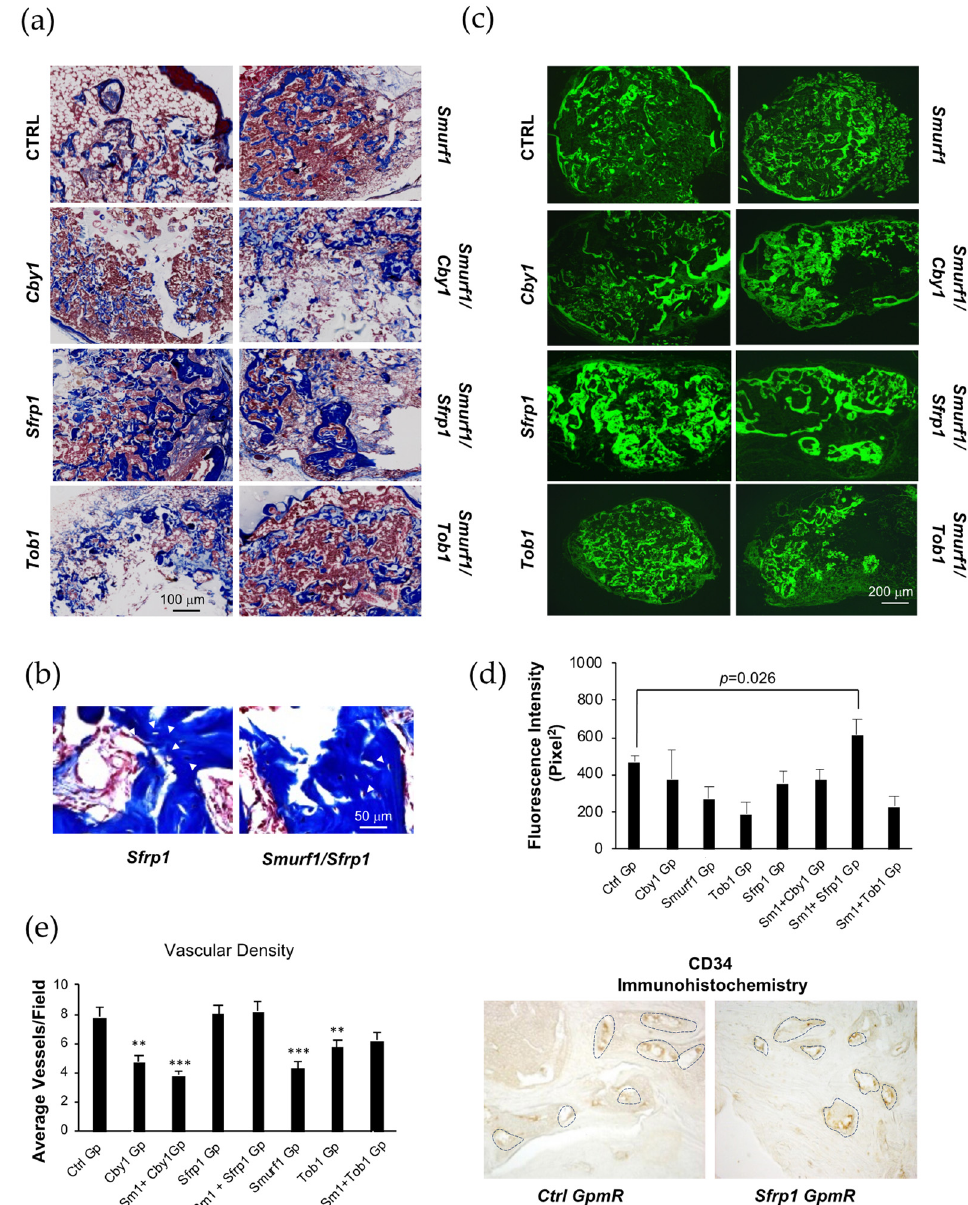
Figure 4. In vivo analysis of the pro-osteogenic effect of the silencing of key osteogenic inhibitors in MSCs. Pictures show histological analysis of sections obtained from representative decalcified implants. All implants were isolated from the same individual. ( a ) Masson–Goldner staining of subdermal implants in mice, showing mineralized matrix. ( b ) Representative images of Masson–Goldner staining at higher magnification. White arrowheads indicate osteocyte-like cells surrounded by lacunae and immersed in the mineralized matrix. ( c ) Histological sections observed under green, fluorescent light show the typical autofluorescence of collagen fibers in the different samples analyzed. ( d ) Bar graph shows quantification of fluorescence signal intensity in the different histological samples performed using ImageJ. Sm1 stands for Smurf1 . One implant of each type was quantified. Values correspond to the average of at least six different areas measured in each of the implants. Error bars represent standard error of the mean values. Sm1 stands for Smurf1 in the Gapmer combinations. ( e ) Immunohistochemistry of vascular marker CD34. Microvascular density was determined by counts of CD34-positive staining blood vessels. Sm1 stands for Smurf1 in the Gapmer combinations. The graph shows the average values and the standard error of at least five different areas analyzed for each sample. Microscopic appearance of CD34-positive staining blood vessels is shown on the right. Stained microvessels are outlined (** p ≤ 0.005; *** p ≤